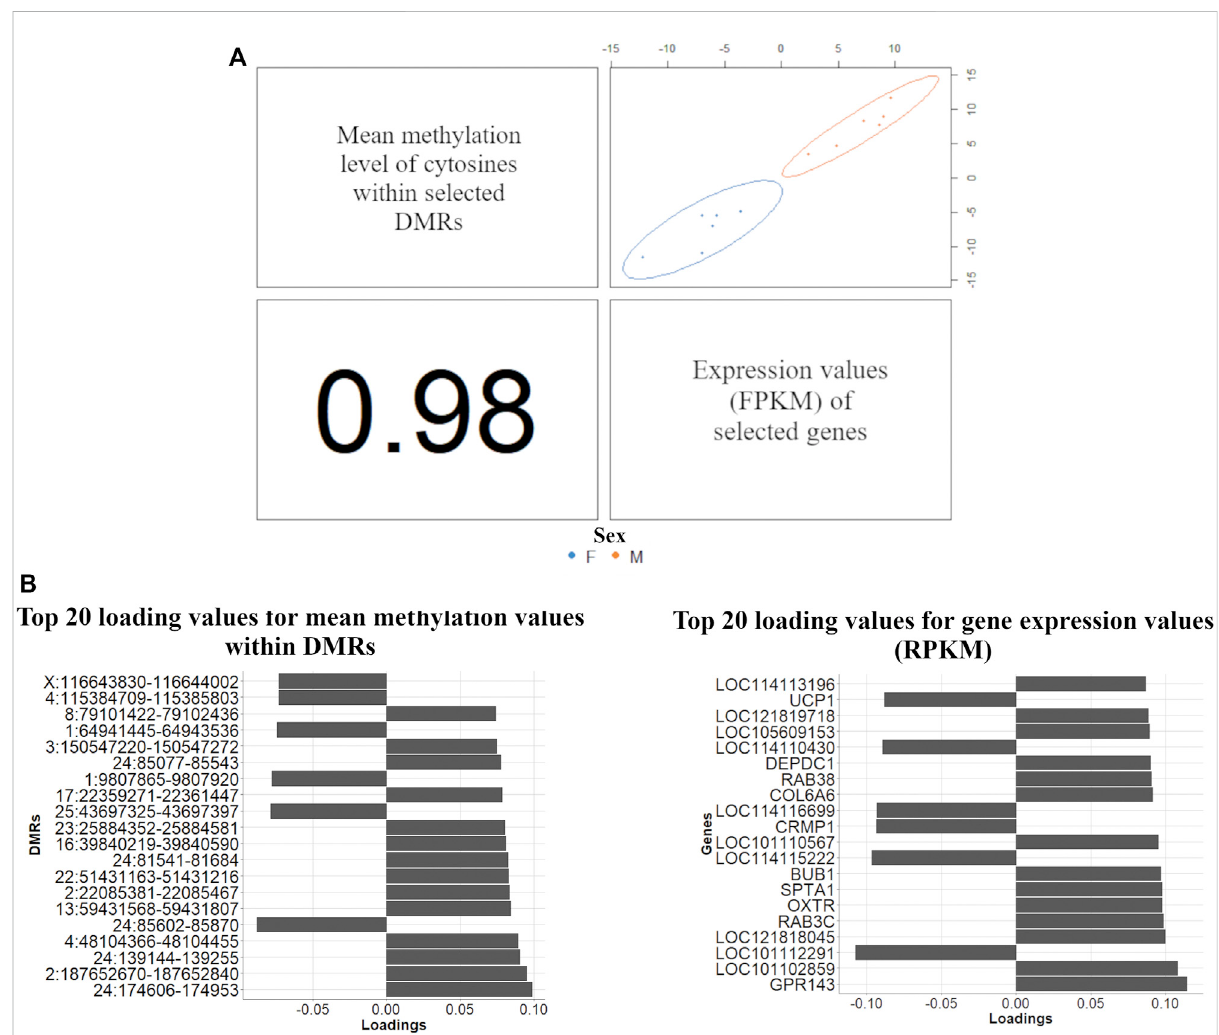
FIGURE 4 Multi-omics discriminant analysis between males (blue) and females (orange) samples using multiblock (s)PLS-DA. (A) Scatterplot from plotDiablodisplayingthe fi rstprincipalcomponentinRNA-SeqandWGBSdatasets(upperdiagonalplot),thus,constructedwithexpressionvaluesof 314 discriminant genes between males and females (RNA-Seq data) and 627 mean methylation levels within DMRs mapped within the same genes (WGBS data), and Pearson correlation (0.98) between each component (lower diagonal plot) (B) Loading values for the top 20 DMRs (left-hand side) and gene expression values (right-hand side) obtained in the multiblock (s)PLS-DA used to discriminate male and female